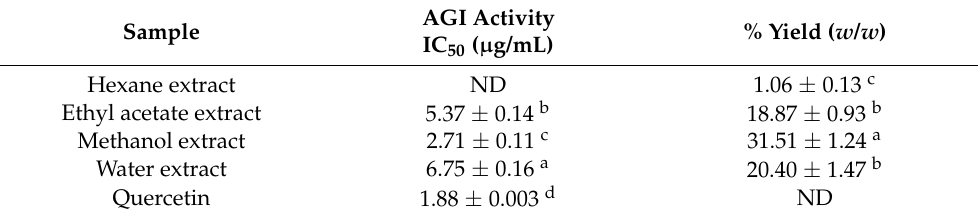
Table 1. The AGI activity and yield of extraction of different extracts of P. malayana